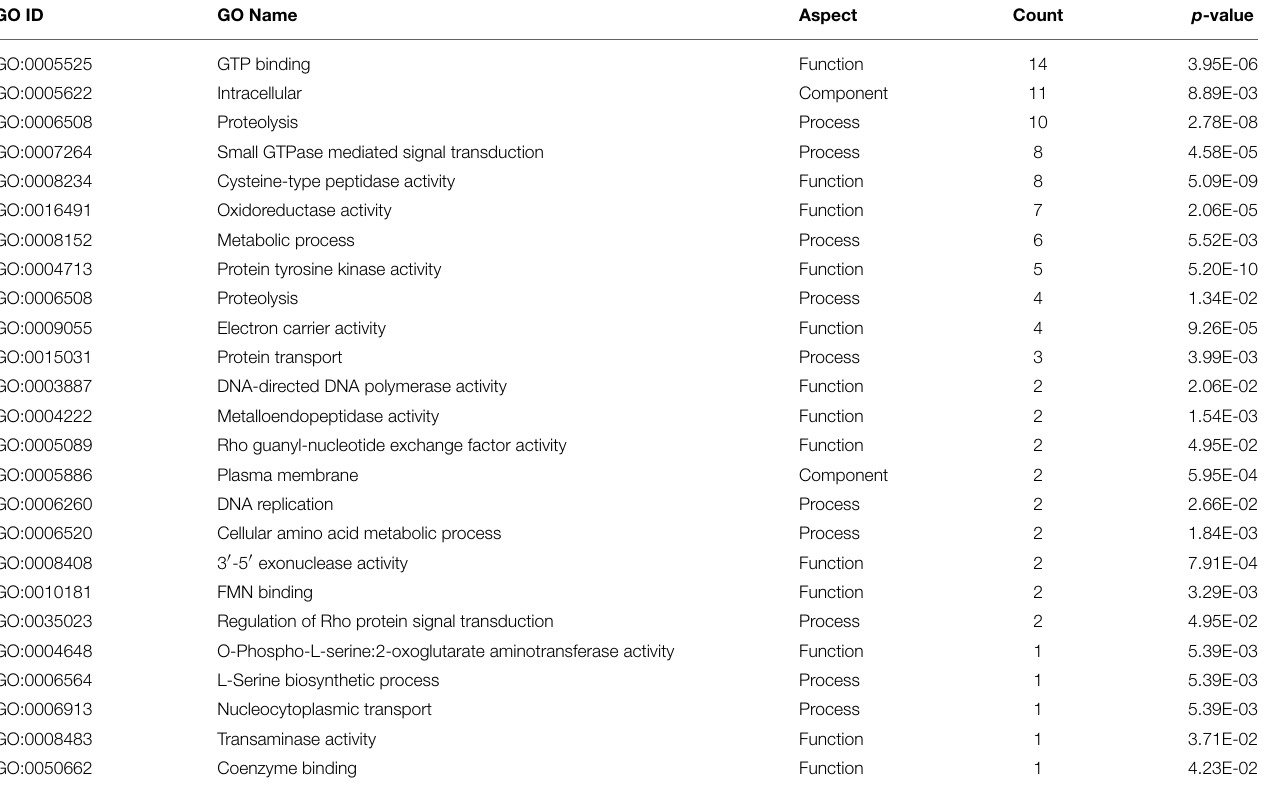
TABLE 5 | List of GO terms that were significantly enriched in